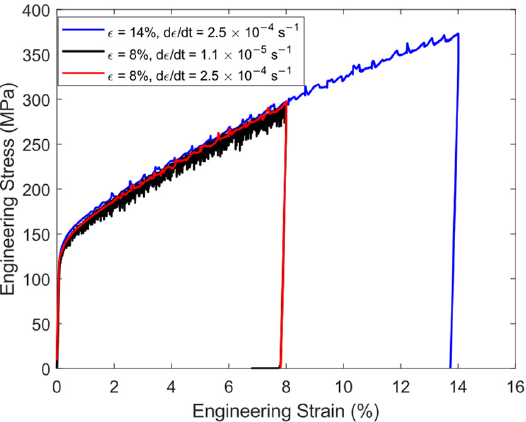
Figure 3. Loading curves of three specimens at 550 °C, highlighting negligible difference despite significantly different strain rates.